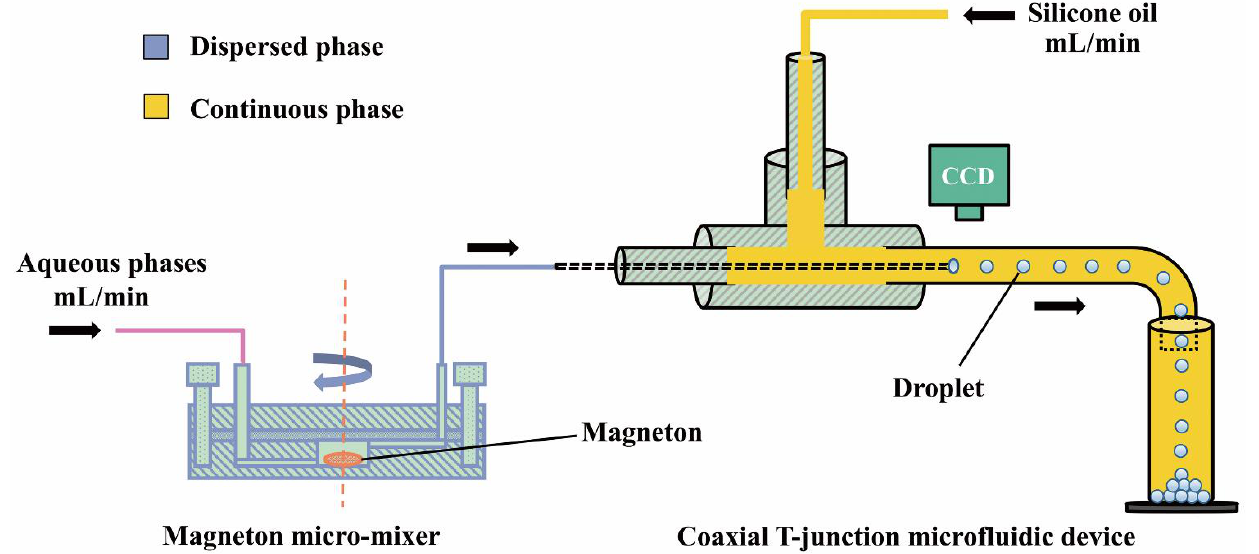
Figure 1. Schematic drawing of the droplet microfluidic system (DMS) for preparing monodis- perse